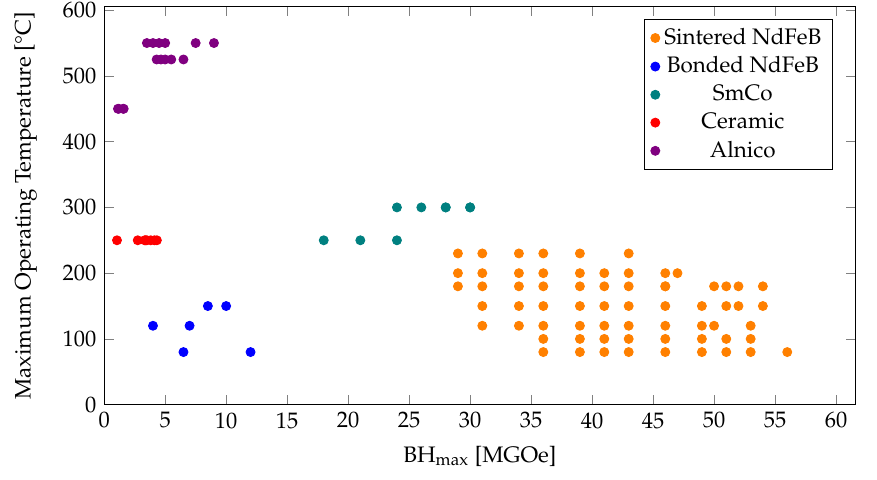
Figure 18. Different grade of magnets BHmax and maximum operating temperature